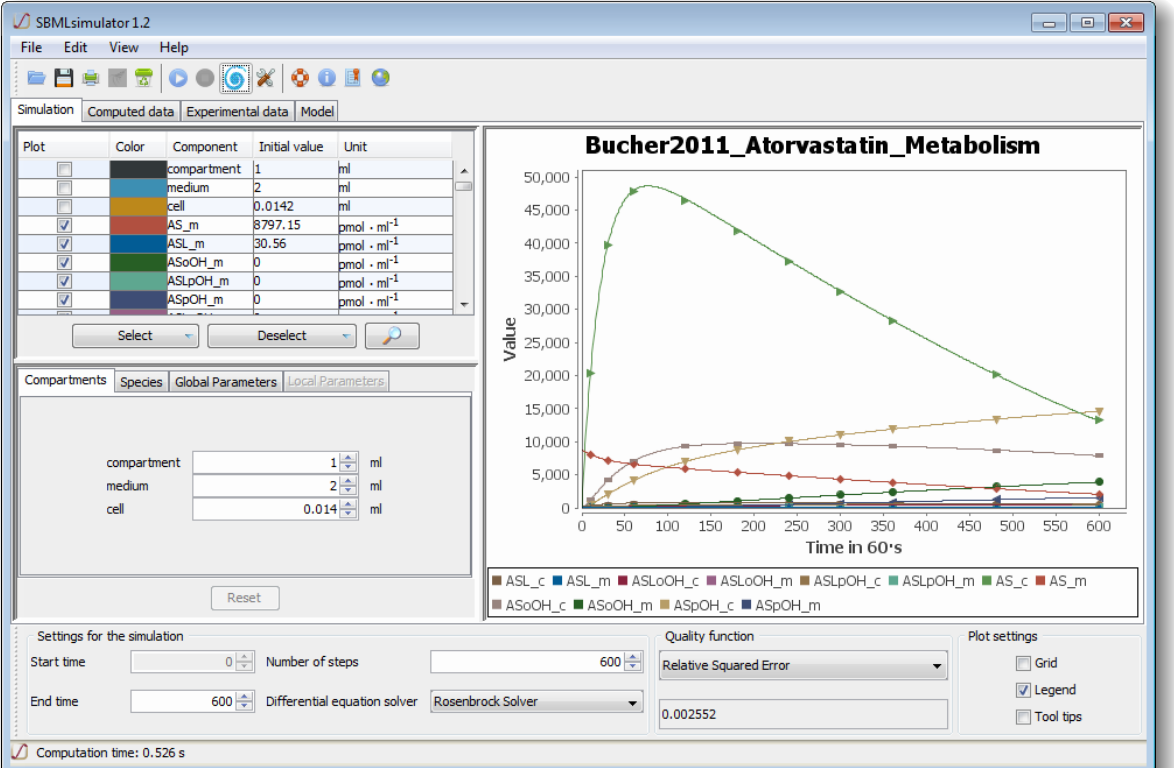
Figure 1. The graphical user interface (GUI) of The Systems Biology Markup Language (SBML)simulator. The figure shows the main window of SBMLsimulator after importing the model by Bucher et